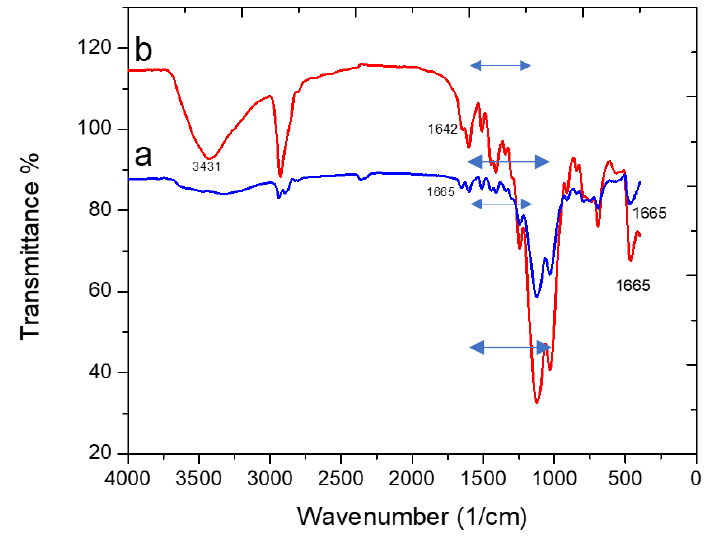
Figure 2. FTIR absorption spectrum of adsorbent 1 , (a) before absorption and (b) after adsorption.